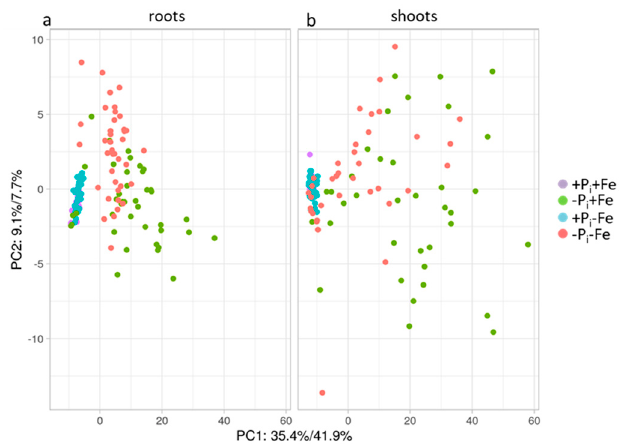
Figure 2. PCA score plots of the different treatments, ( a ) Col-0 roots; ( b ) Col-0 shoots. After an initial growth period of five days on nutrient sufficient conditions (+P i +Fe), seedlings were transferred to the indicated conditions and allowed to grow for an additional six days before harvest. +P i : 500 µM,